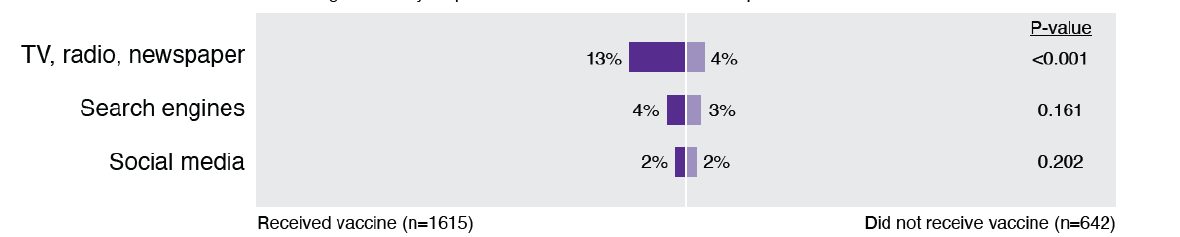
Figure 5. Differences in trust in media between vaccinated and unvaccinated EMS professionals.